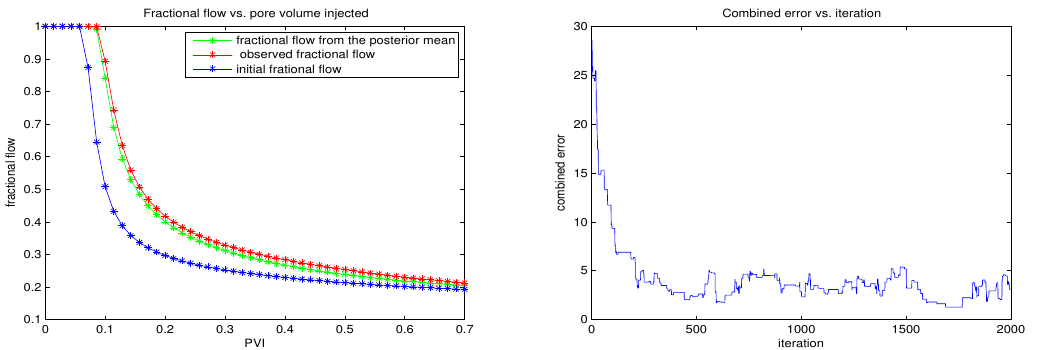
Figure 8. Left : Red line designates the fine-scale reference fractional flow of oil, the blue line designates the initial fractional flow of oil, and the green line designates fractional flow of oil corresponding to mean of the sampled permeability field from two-stage MCMC. Right : Fractional flow errors vs. accepted iterations when sampled from the posterior distribution retaining 20 terms in K-L